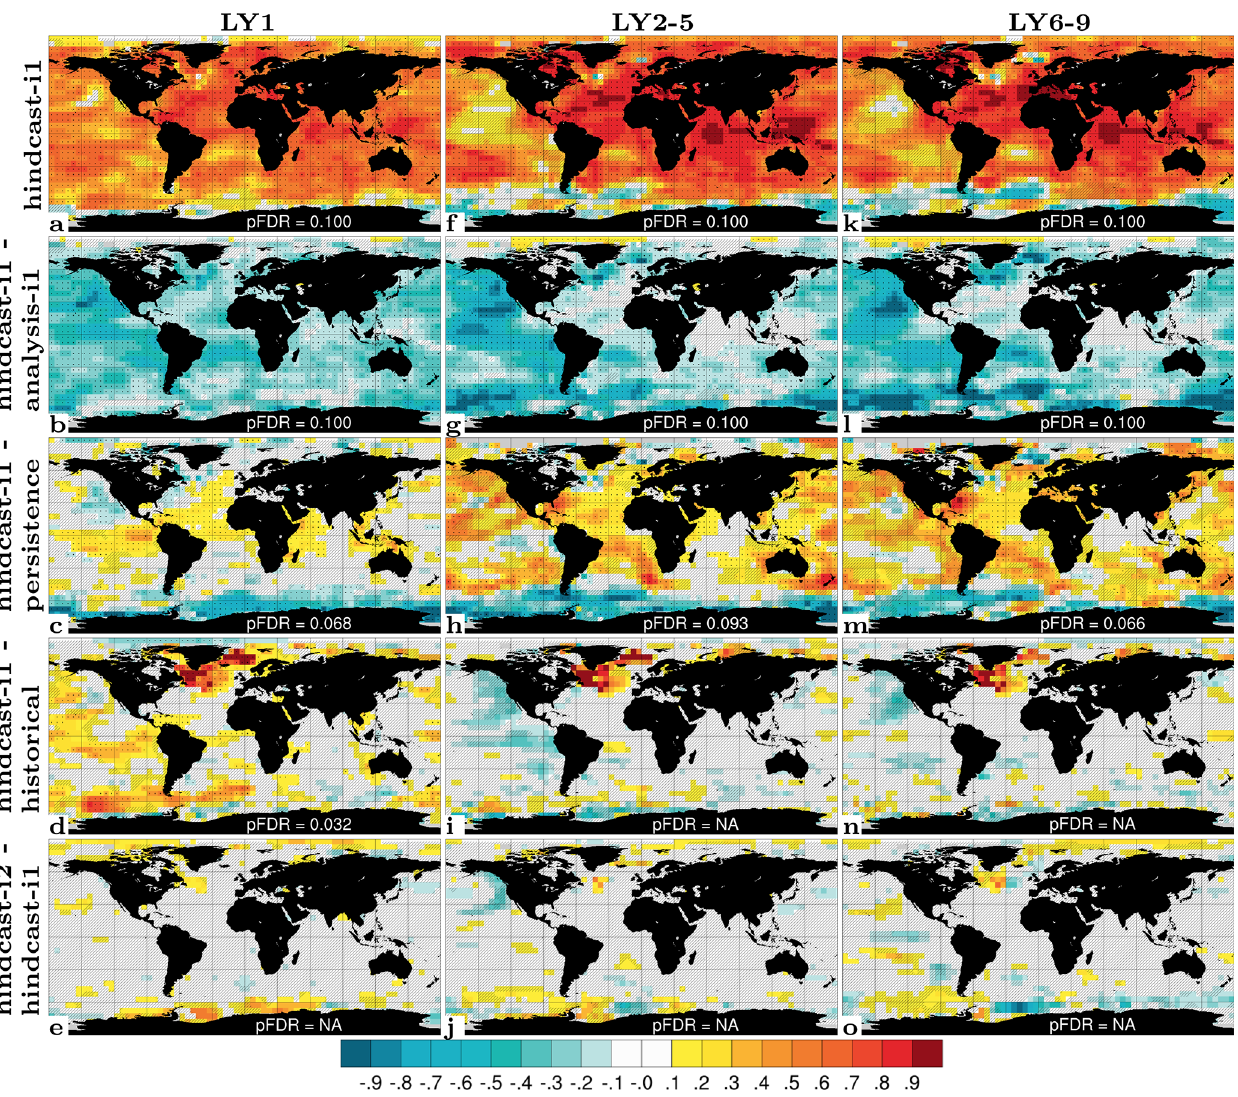
Figure 11. Prediction skill for SST. ACC of hindcast-i1 (a) , (cid:49) ACC of hindcast-i1 – analysis-i1 (b) , (cid:49) ACC of hindcast-i1 – persistence (c) , (cid:49) ACC of hindcast-i1 – historical (d) and (cid:49) ACC of hindcast-i2 – hindcast-i1 (e) for LY1. The middle and right columns show the same but for LY2–5 (f–j) and LY6–9 (k–o) . Observations use ERSSTv5 (Huang et al., 2017) with coverage for 1960–2018. Hatched areas are not locally significant; dotted areas are field